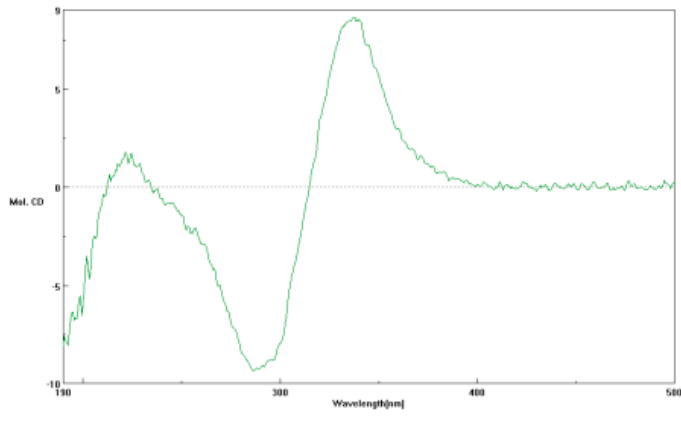
Figure 3. The CD spectrum of penicitroamide ( 1 ) in CH 3 OH.